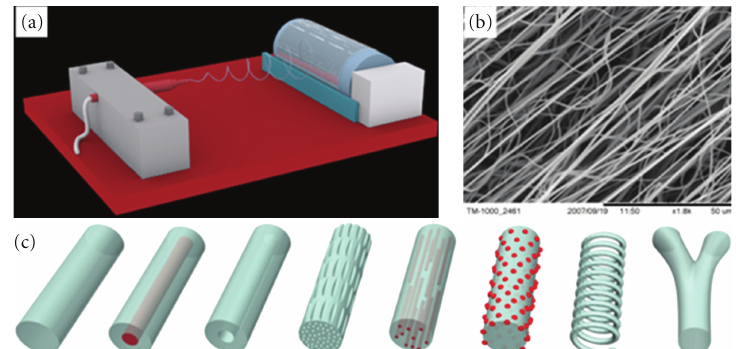
Figure 1: Nanofibers: electrospinning nanotechnology. (a) Scheme demonstrating principle of electrospinning technology and electrospinning apparatus; (b) Electrospun tissue engineered sca ff old (scanning electron microscopy), (c) Scheme demonstrating di ff erent diverse classes of nanofibers that can be obtained by electrospinning. Shown are, from left to right, solid, core-shell, hollow, porous, composite, decorated, spiral, and branched nanofibers